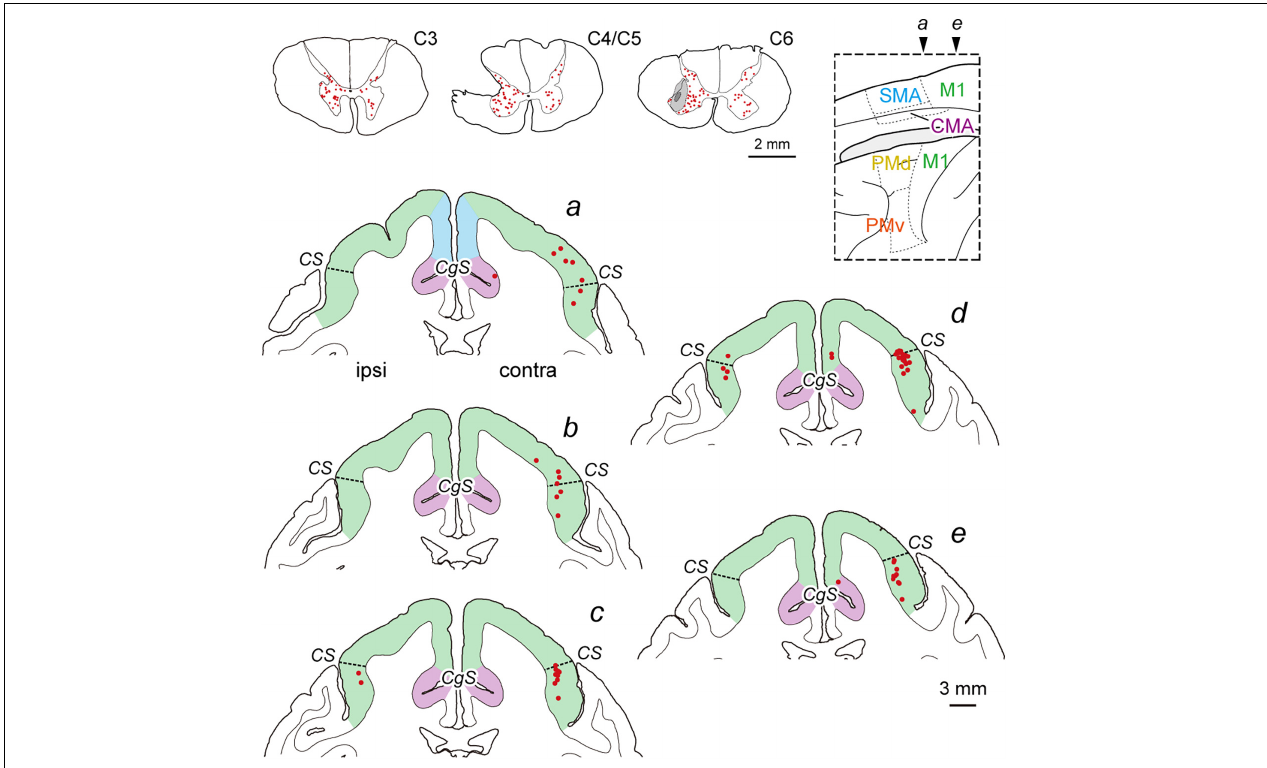
FIGURE 2 | Distribution of diCSP neurons immediately after SCI (monoCSP lesion) 3 days after rabies injections into the spinal forelimb segments (C6–T1) (Experiment C). Representative transverse sections showing retrograde labeling in the upper cervical segment, the maximum extent of SCI, and the site of rabies injection are depicted in sections C3, C4/C5, and C6, respectively (top left; monkey C1). Lesions in our SCI model were made to completely involve the dorsolateral CSP linking the cortex monosynaptically to the forelimb segments, and the rabies injections were performed immediately after SCI. The injections were placed around lamina IX where the spinal motoneurons are distributed. The dark gray region in section C6 represents the injection needle track, and the surrounding light gray region denotes the extent of the injection site. Numbers of neurons are labeled bilaterally in the upper cervical segments, including the propriospinal neurons projecting to the forelimb motoneurons. Distribution of retrograde labeling in the frontal motor-related areas of the same monkey are shown in five representative coronal sections ( a –e). The second-order neuron labeling is located mostly in the contralateral M1. Note that the cortical areas anterior to section a are virtually devoid of labeled neurons. Other conventions are as in Figure 1